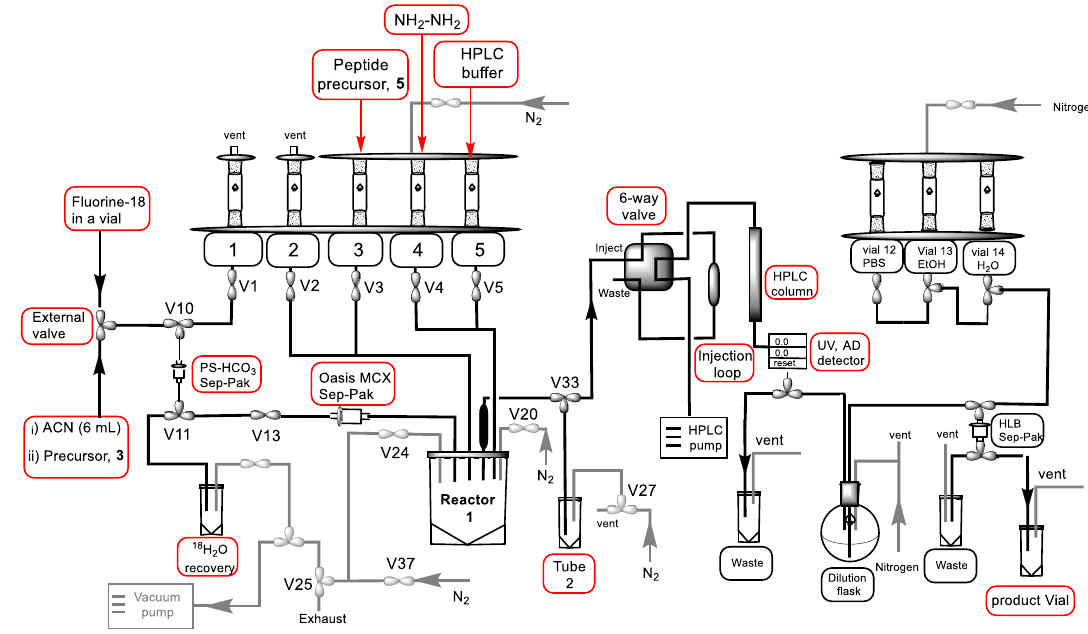
Figure 3. Schematic diagram of the automated synthesis of 6-[ 18 F]FPy-CONH-T140 on GE FX-N Pro Module.